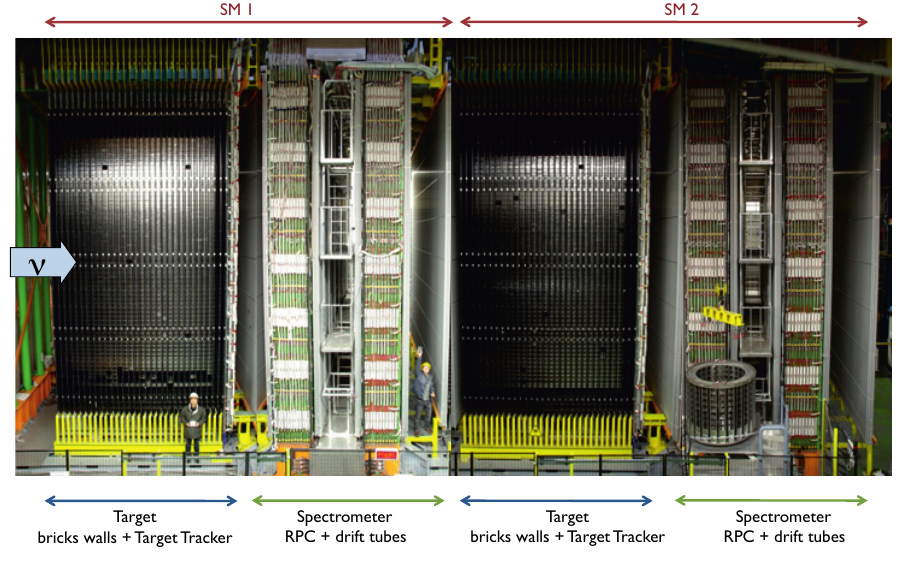
Figure 1. The OPERA detector in the Hall C at